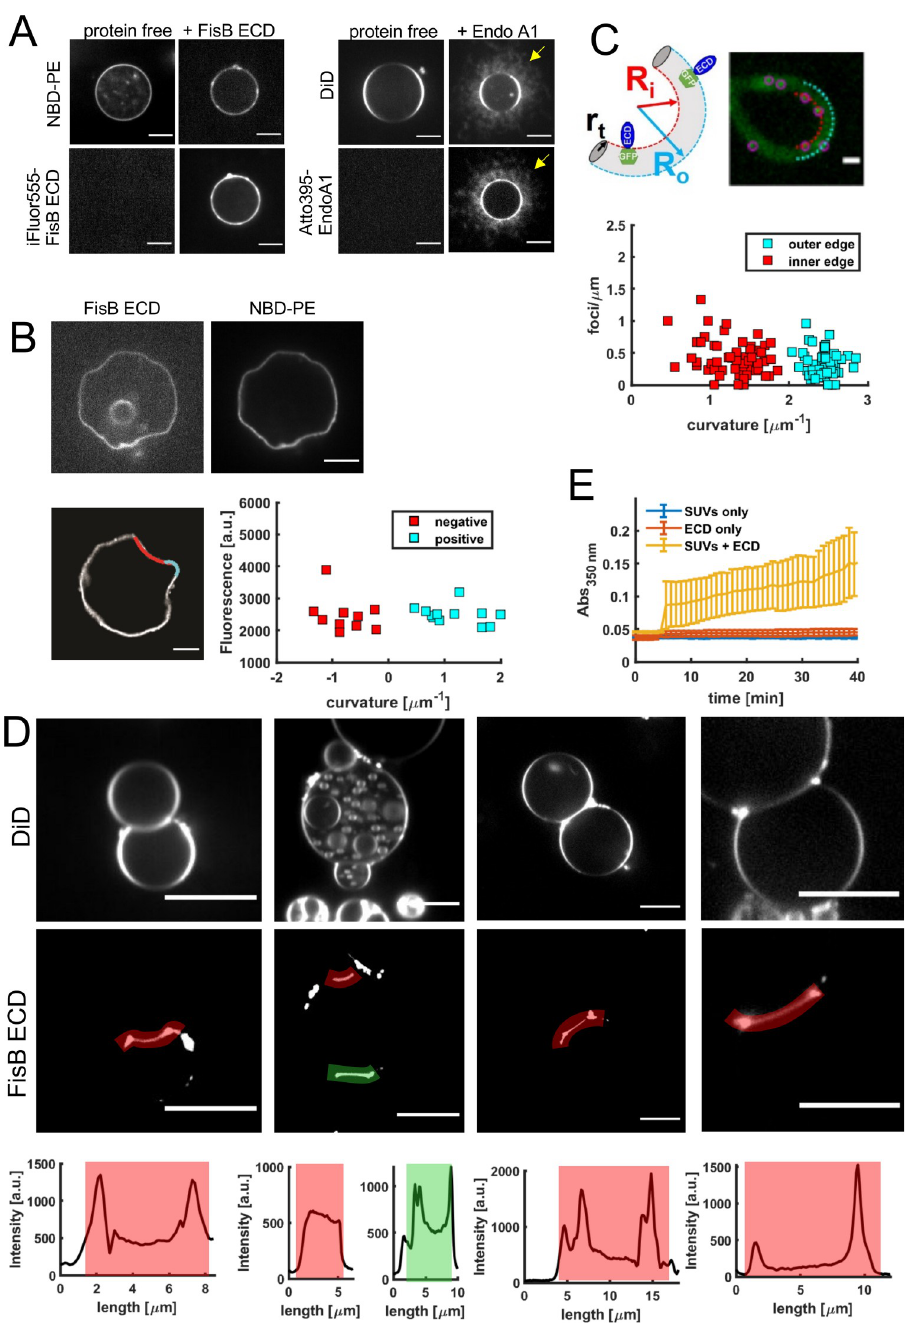
Fig 8. FisB does not sense or induce membrane curvature. (A) FisB ECD does not induce deformation of GUV membranes. Left: GUVs incubated with 2 μ M iFluor555-FisB ECD did not show any tubulation or invagination of the GUV membrane. GUVs were composed of (in mole %: 25 E . coli PE, 5 E . coli CL, 50 E . coli PG, 19 eggPC, and 1 NBD-PE). Right: incubation of 2 μ M endophilin A1 (EndoA1, labeled with Atto395) with GUVs (45% DOPS, 24.5% DOPC, 30% DOPE, and 0.5% DiD) resulted in extensive tubulation of membranes (arrows), as reported previously [22]. The 2 proteins have similar affinities for GUV membranes under these conditions (Fig 4F and [69]). (B) FisB ECD cannot deform deflated GUVs and its membrane localization is independent of curvature. To avoid potential issues with high membrane tension preventing membrane deformation, GUVs were deflated using osmotic stress, which resulted in deformed GUVs with both negatively and positively curved regions. FisB ECD bound to these GUVs was unable to induce any high-curvature deformations. The intensity of iFluor555-FisB ECD along a membrane contour (proportional to coverage) was plotted against membrane curvature in the corresponding region. There